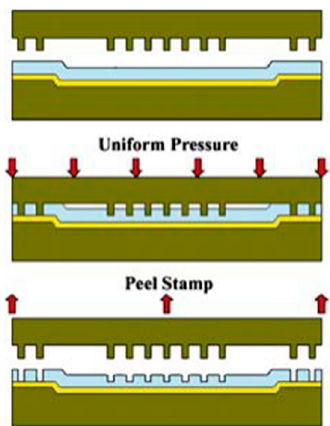
Figure 20. Schematic representation of the PDMS through-hole membrane fabrication steps via imprinting/soft molding, adapted from [131] .